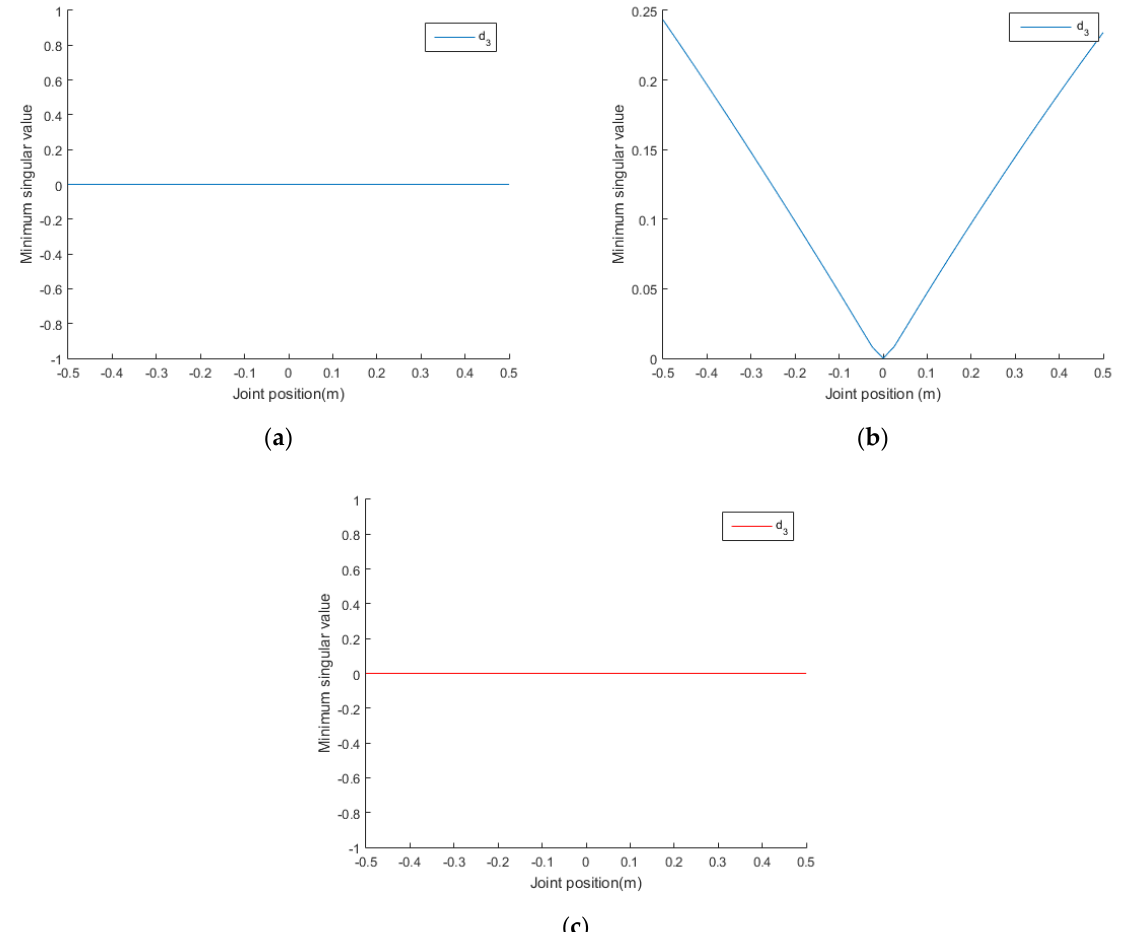
d ; ( b ) setting 3 = 0, ± π rad, the distribution of d ; ( c ) setting rad, the 3 ; ( c ) setting q 5 3 d . 3